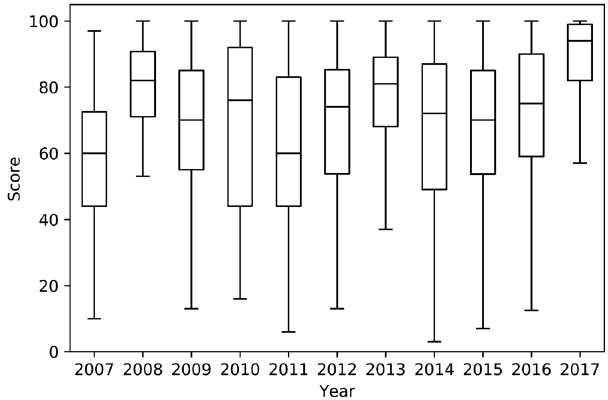
FIG. 1. Raw score distribution of grades on the first calculus- based mechanics exam by year. For each box, the middle line represents the median, the box represents the two middle quartiles, and the error bars represent the highest and lowest